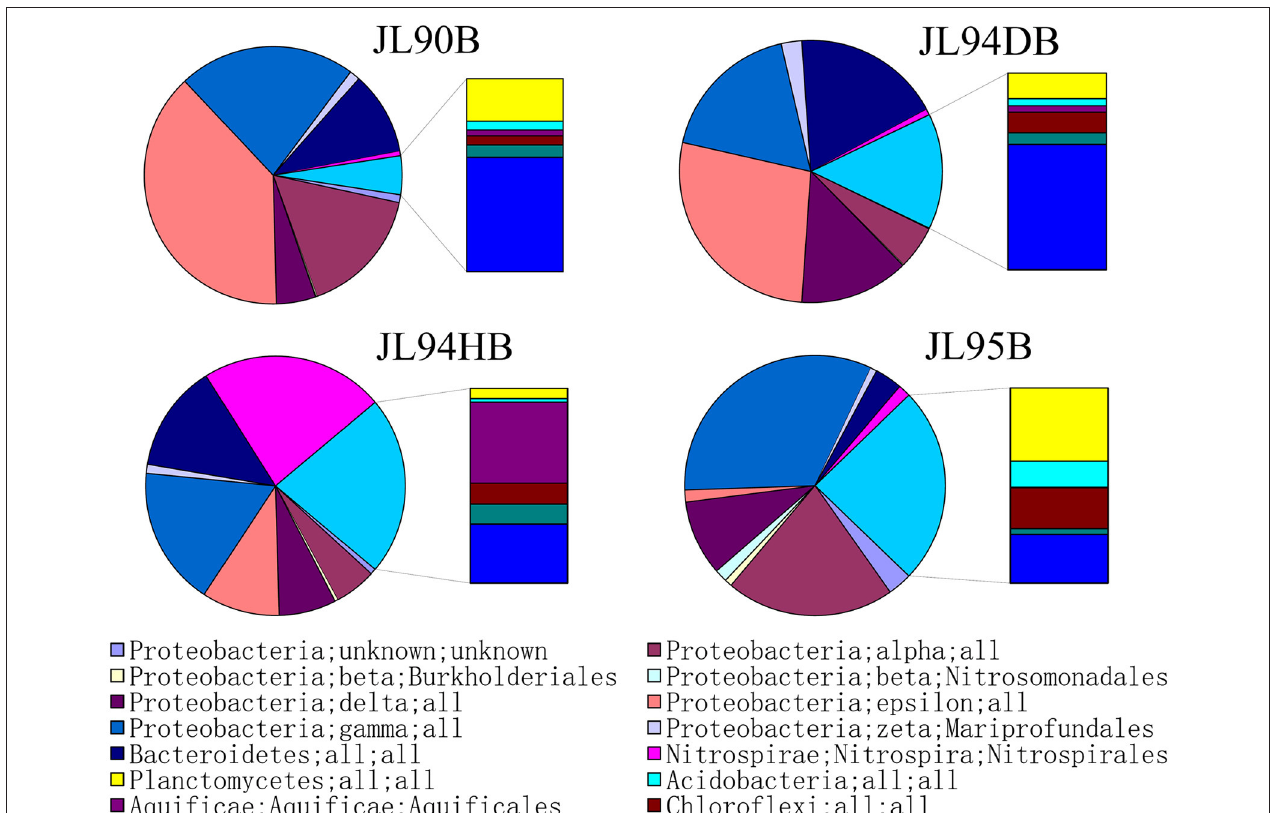
FIGURE 4 | Taxonomic breakdown of bacterial 16S rRNA V4-region tags from each chimney sample. Pie Charts show Phylum; Class; Order distribution (The average relative abundance among samples is over 1%) for taxomomically assigned tags that occurred more than 1,000 times; the remaining tag sequences are grouped into